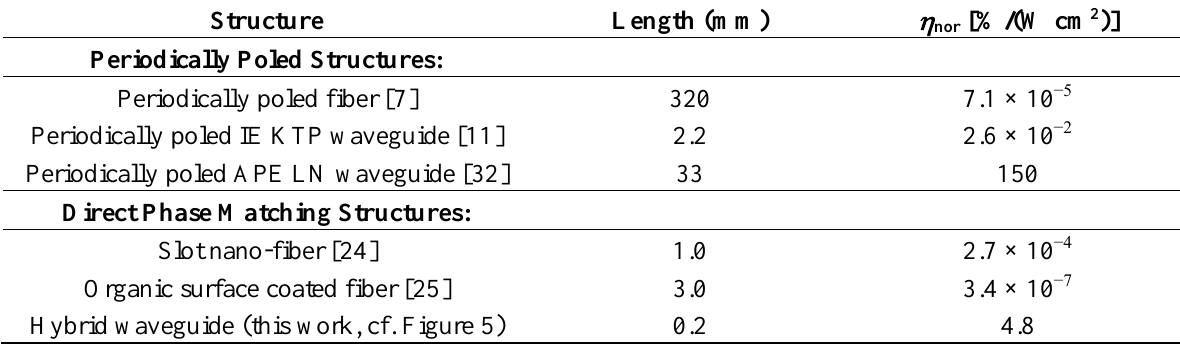
Figure 5. Normalized efficiency of second harmonic generation (SHG) in the structure with random variations of the waveguide width W : solid curve corresponds to  averaged over 1000 realizations, dashed curve indicates efficiency in the ideal structure without variations, solid red/grey curve corresponds to a particular random structure shown with the light-grey curve. Table 1. Normalized SHG conversion efficiency [32],  nor =  / L 2 , for different